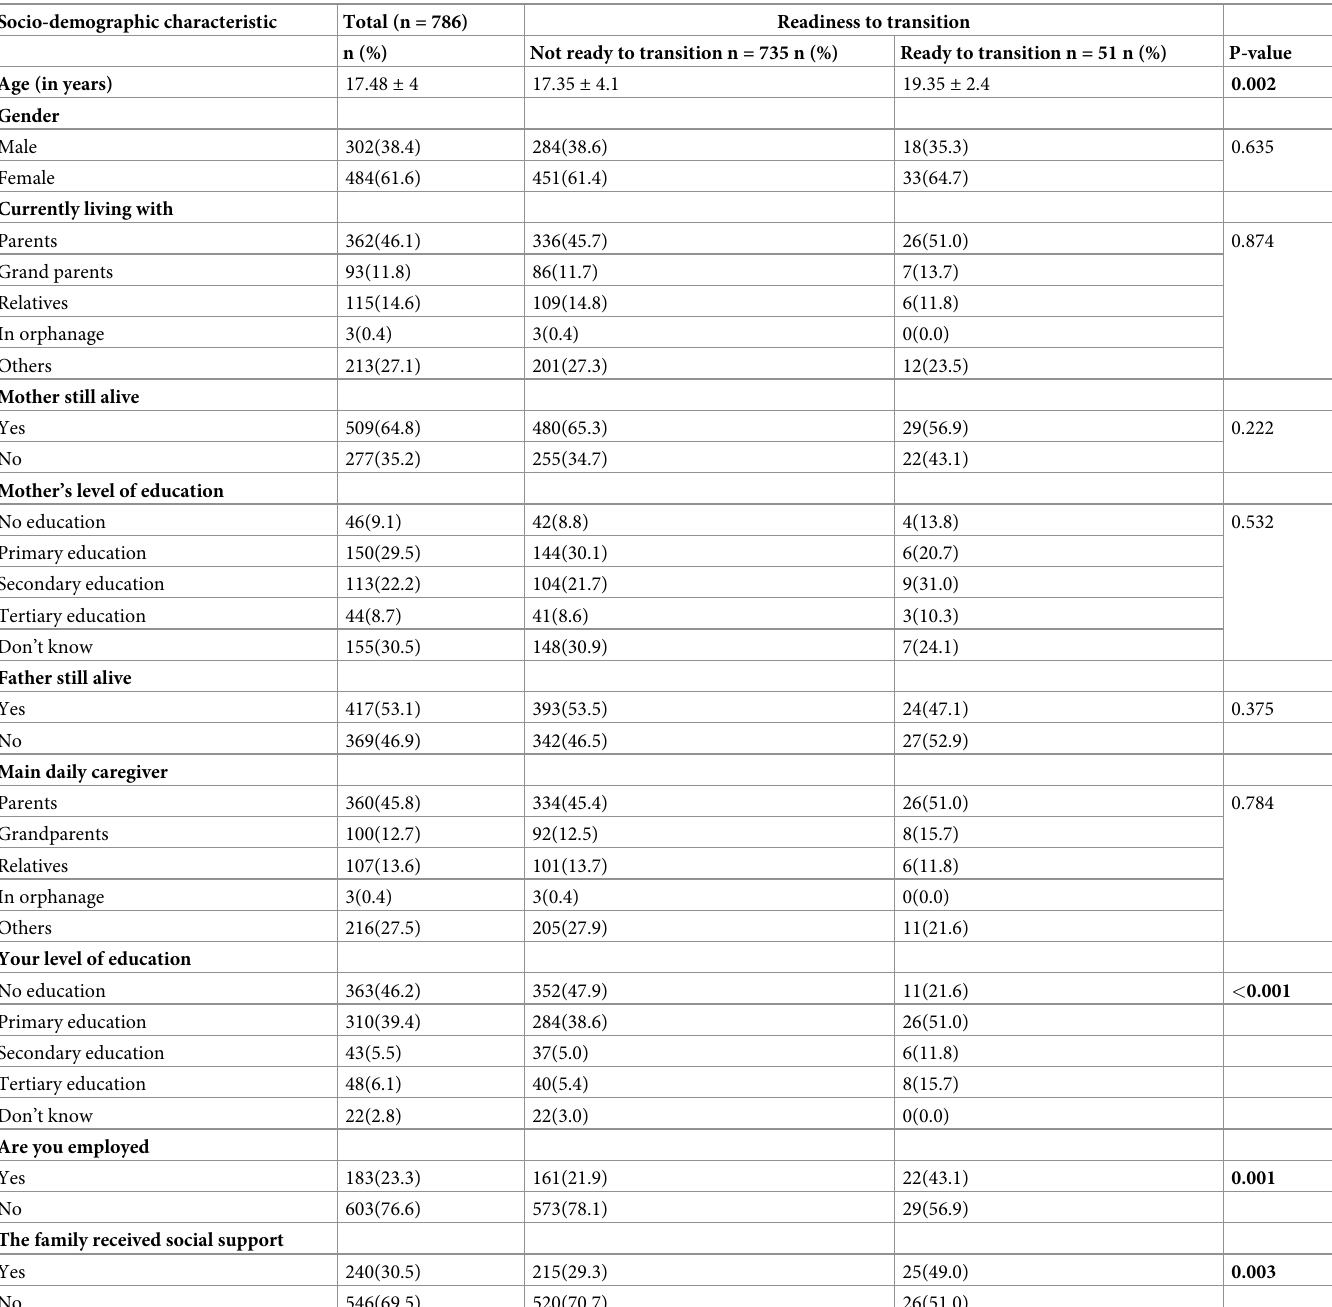
Table 1. Socio-demographic characteristics of the participants and their transition readiness. Socio-demographic